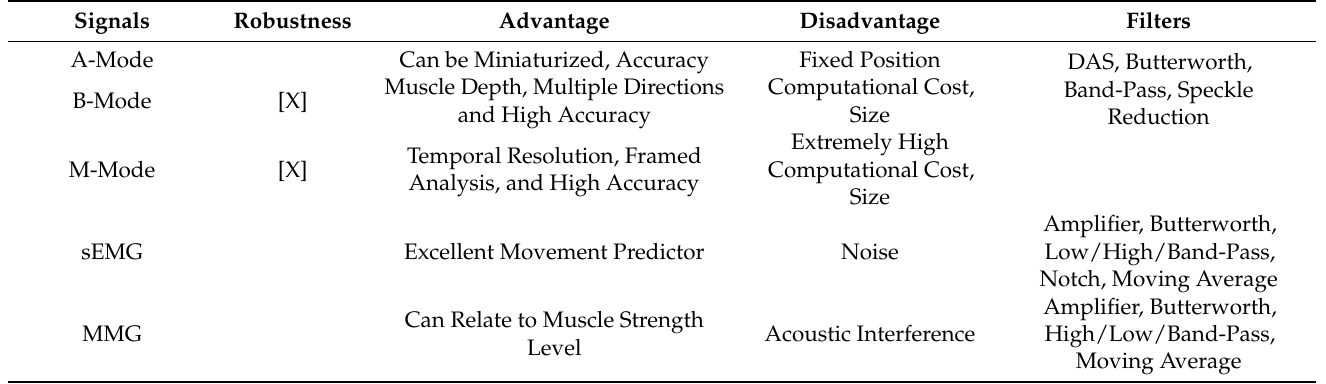
Table 3. Biosensing signals for HMI